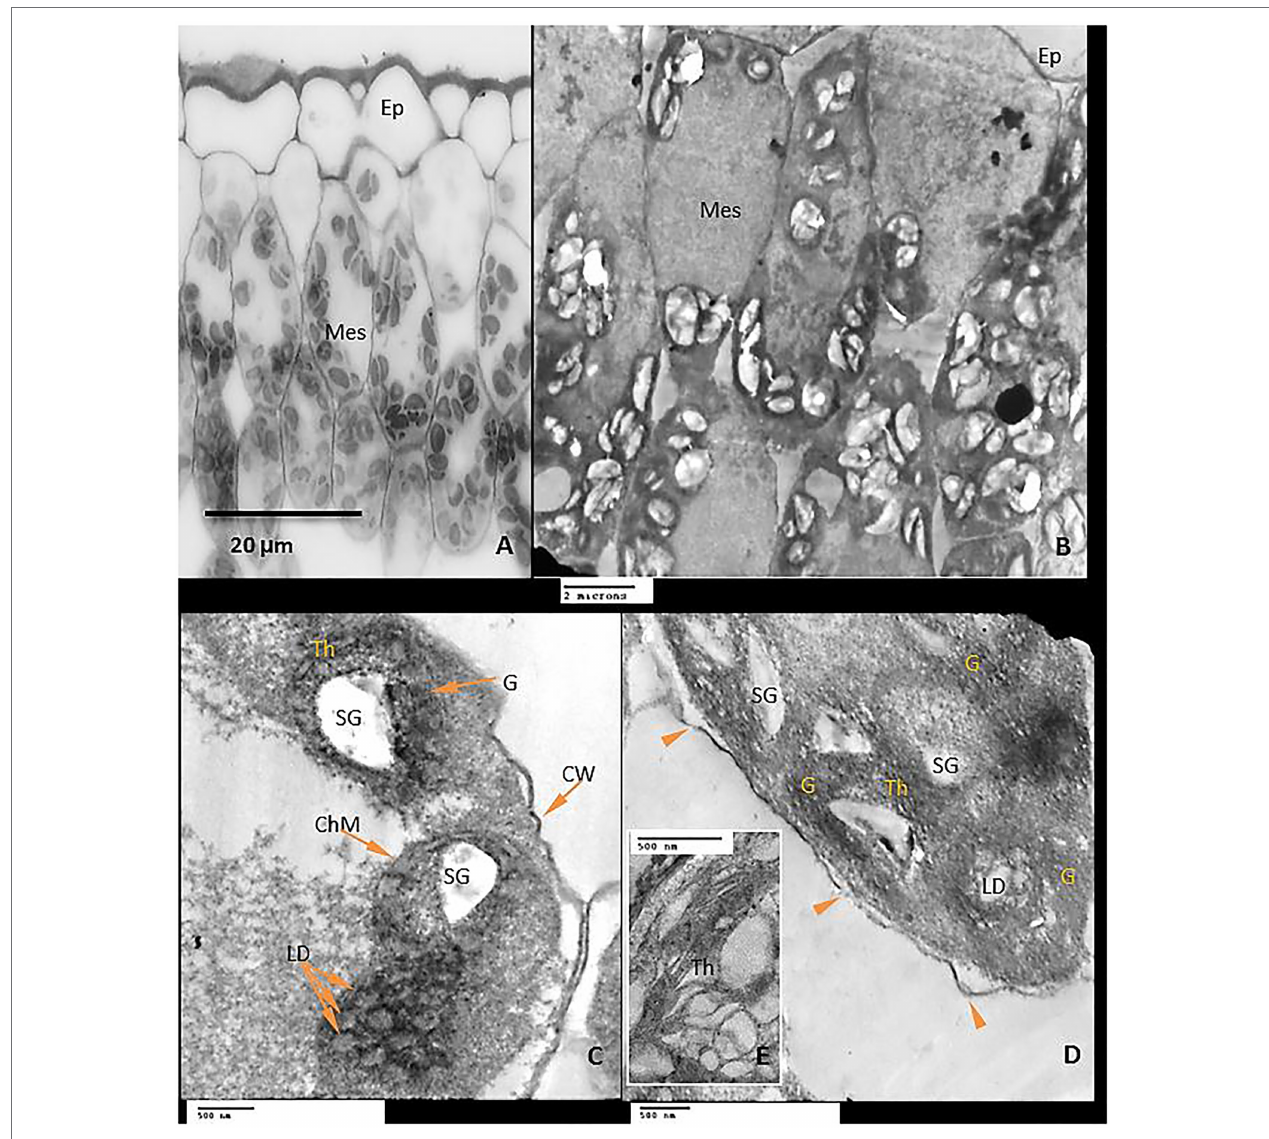
FIGURE 10 | Anatomical structure of Tomato leaf cv “Super marmende” growing under chilling conditions 5 days/4ºC for 6 h/day. (A) Leaf cross-section showed the upper epidermis (Ep) and the two mesophyll layers (Mes); note that chloroplasts were accumulated together in clusters. (B) TEM micrograph showed mesophyll ultra-structures: Chloroplasts became swollen with more rounded shape. (C) High magnification of two chloroplasts showed large starch spherical grains (SG) with accumulation of lipid droplets (LD) in stroma and the membranes of granal (G) and stromal thylakoids (Th) were indistinct. (D,E) , note the unstacking of grana and dilation of thylakoids. Arrowheads pointed to disintegration the outer cellular membrane which disconnected partly from the cell